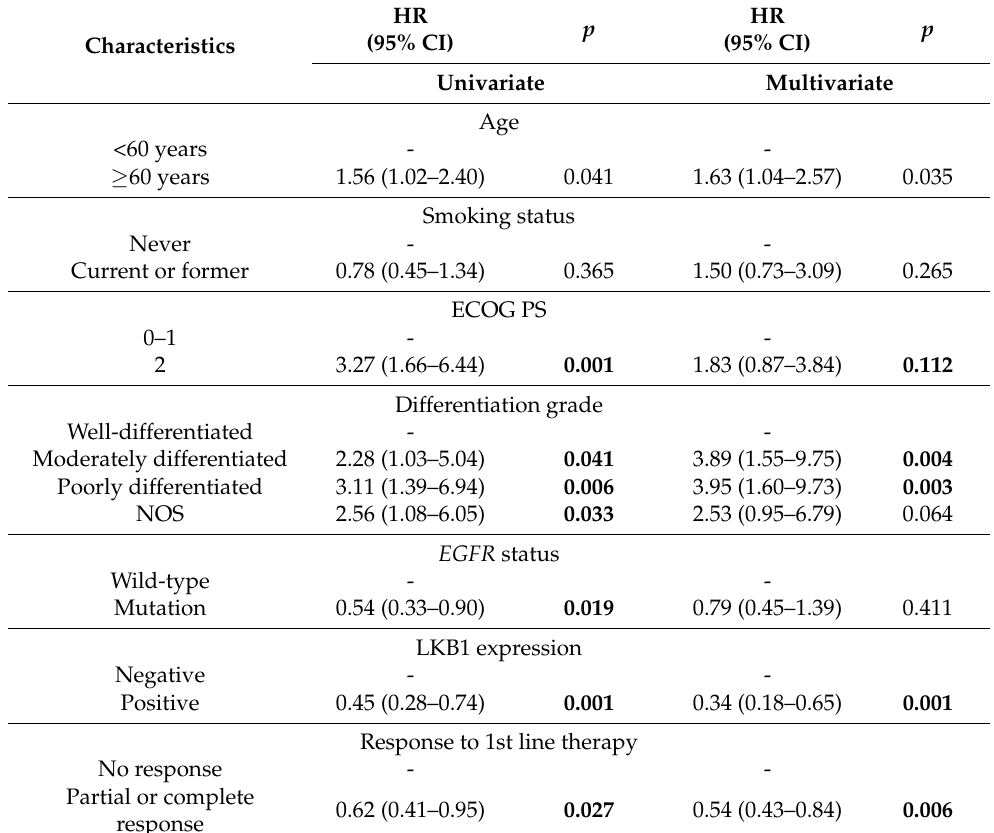
Table 3. Univariate and multivariate analysis evaluating main clinical factors for overall